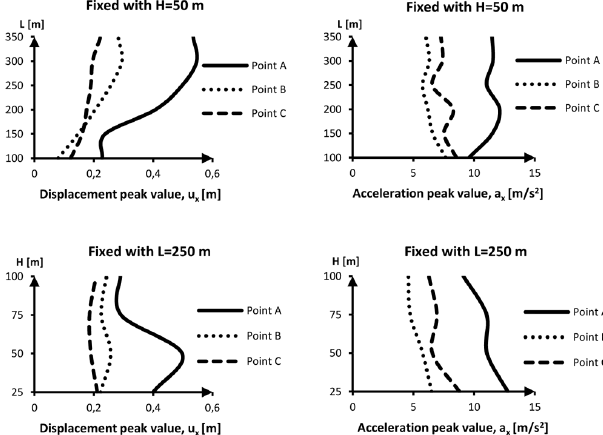
Fig. 2. Effect of mesh size on peak seismic response of proposed SSI